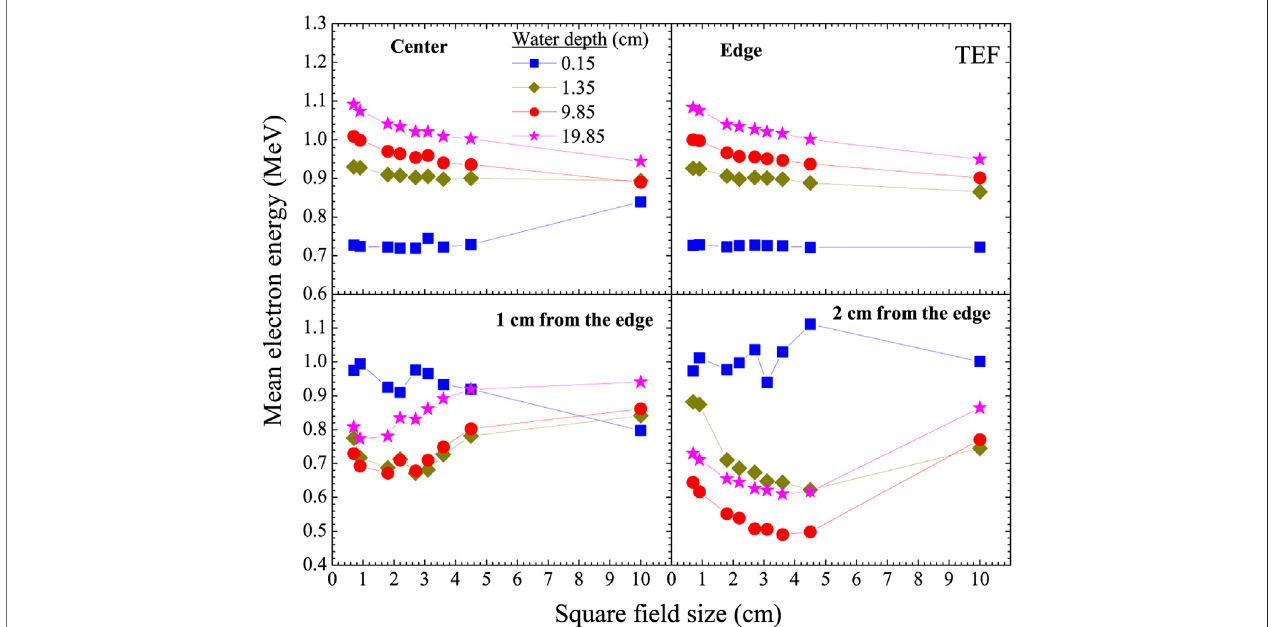
FIGURE 4 | Mean electron energy for the TEF as a function of square FS for four water depths and several OADs.